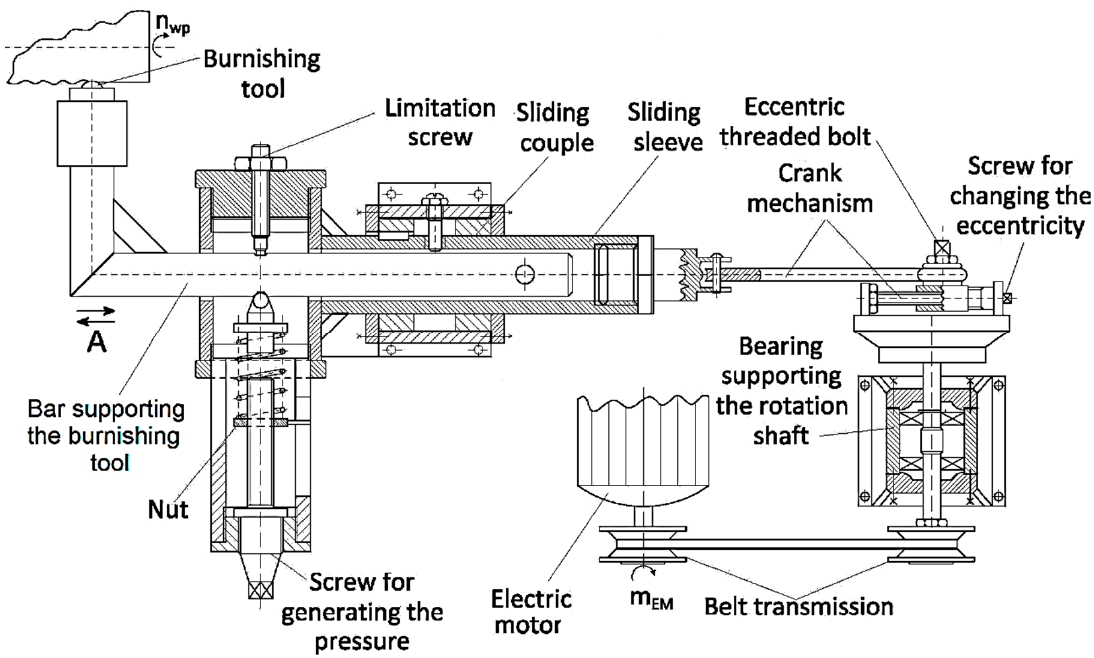
Figure 5. Device adapted on universal lathes to materialize vibroburnishing and oscillatory burnishing of the workpiece surface layer [26].